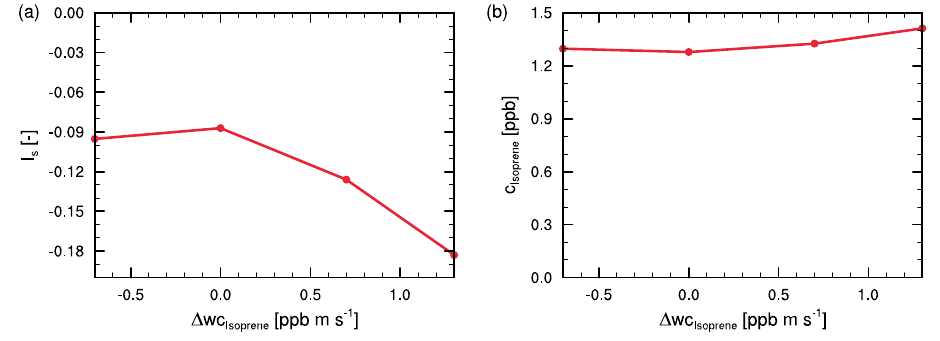
Fig. 12. Dependency of the intensity of segregation in the boundary layer for Reaction (R9) (a) and the boundary layer averaged concentration of isoprene (b) on the difference in isoprene emissions between forest and savannah areas. The average isoprene emission is 0.65ppbms − 1 . The plotted variables are averages over the fourth hour of simulated time and the whole boundary layer. The values on the bottom axis are equal to w 0 c 0 Isoprene , forest − w 0 c 0 Isoprene , savannah